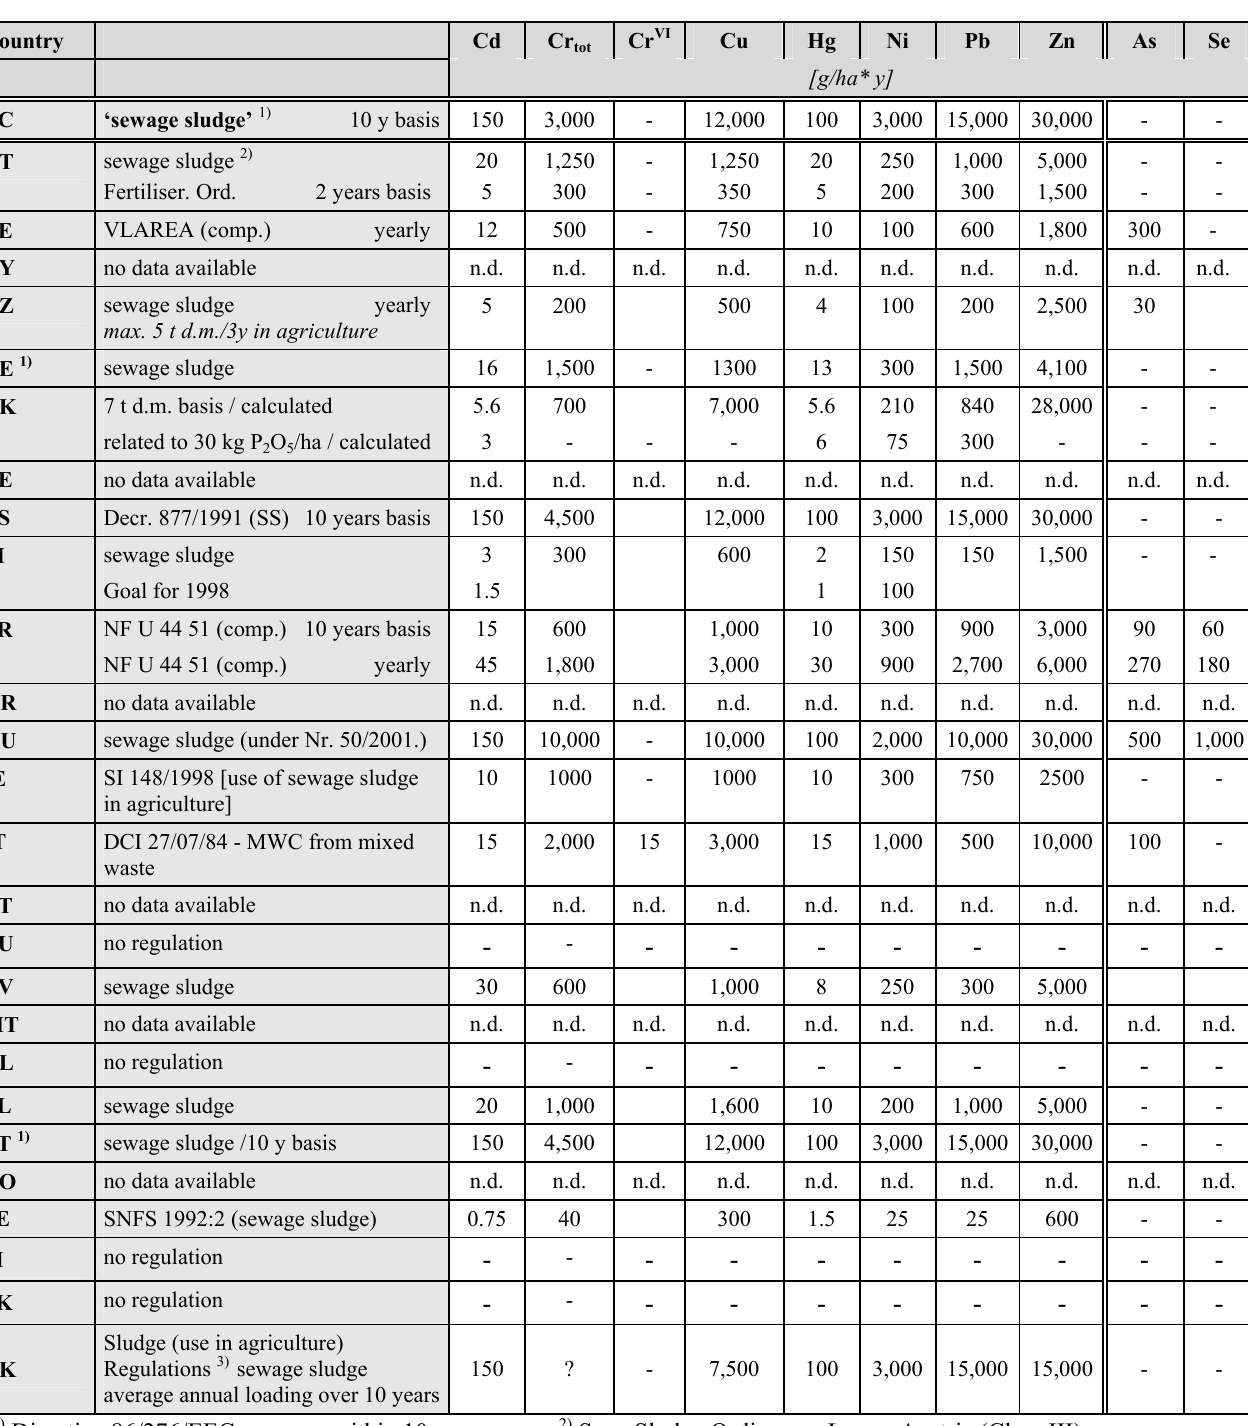
Table 29: Admissible maximum dosage of heavy metals to the soil in national legislation and standards [g/ha*